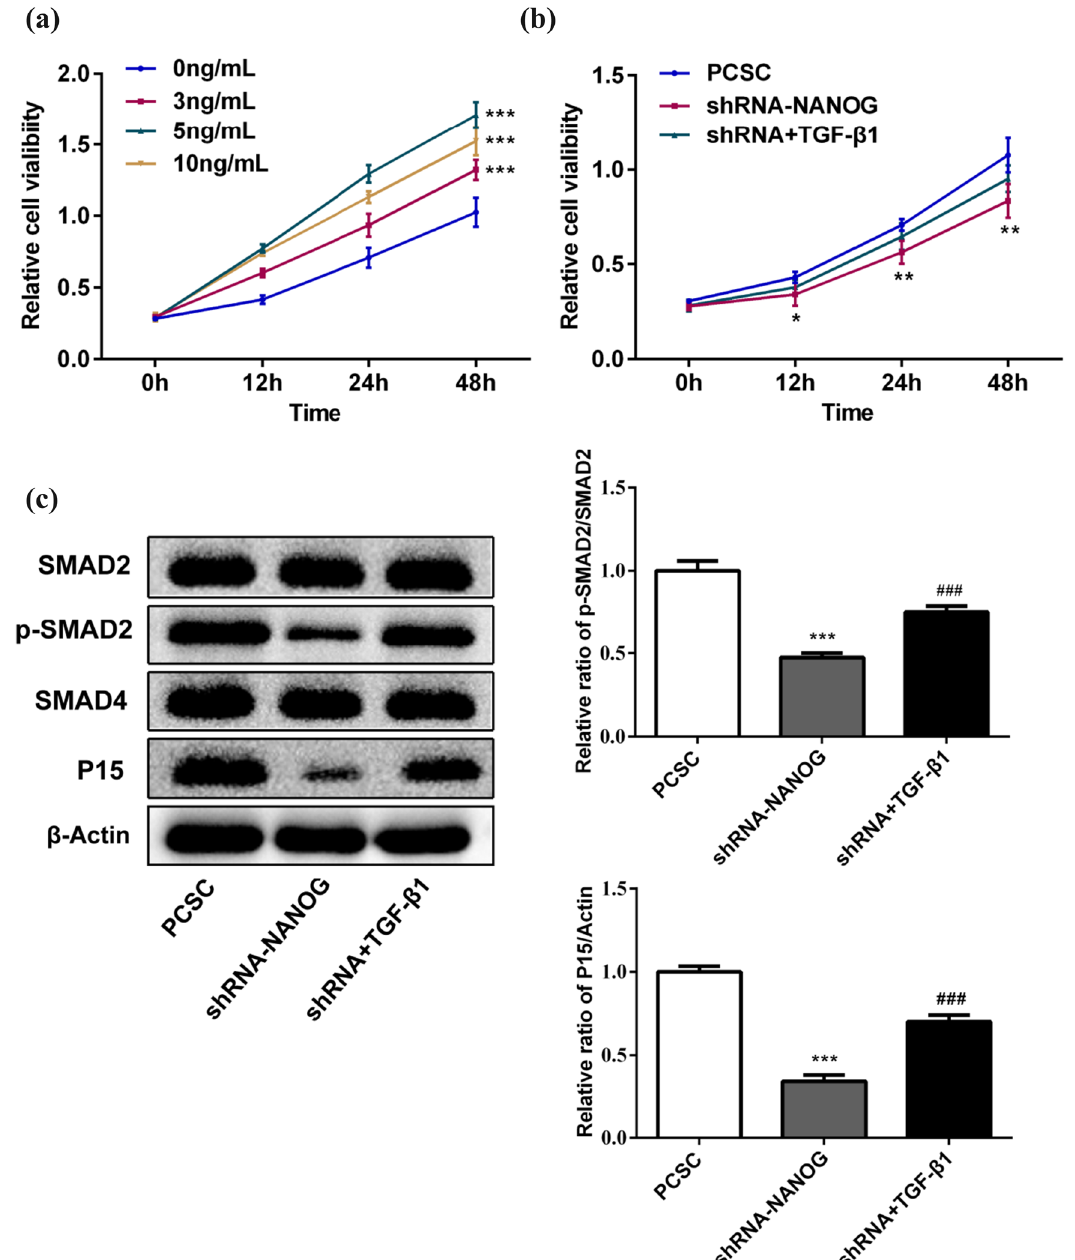
Figure 5: TGF - β 1 rescued the proliferation inhibition induced by shRNA - NANOG. ( a ) The e ff ect of TGF - β 1 on PCSC proliferation was detected by MTT assay. *** p < 0.001 compared to the 0 ng/mL group. ( b ) The e ff ect of TGF - β 1 on the proliferation inhibition induced by shRNA - NANOG was detected by MTT assay. * p < 0.05 and ** p < 0.01 compared to the PCSC group. ( c ) TGF - β 1 intervention increases the expression of p - SMAD2 and P15 in shRNA - NANOG cells. *** p < 0.001 with the PCSC group; ### p < 0.001 compared to the shRNA - NANOG